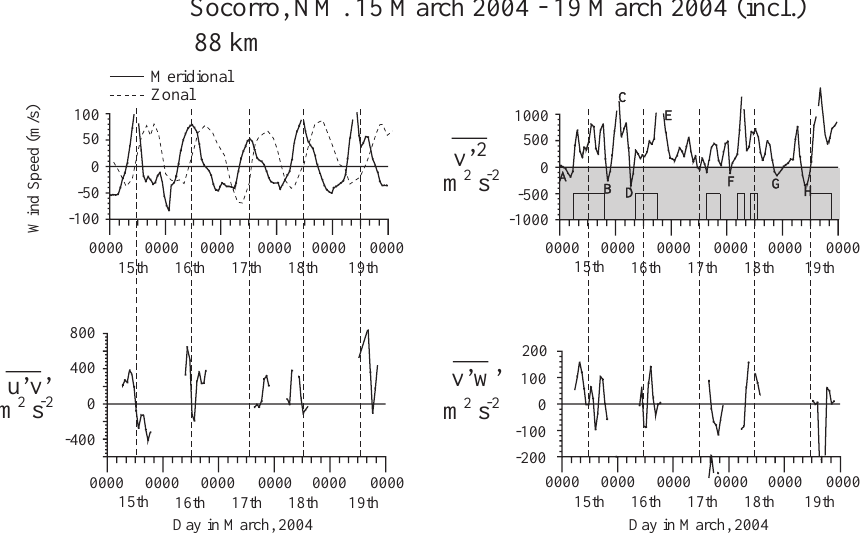
Fig. 1. Examples of mean winds (upper left), northward gravity wave variance (upper right), northward flux of zonal momentum (and also the eastward flux of meridional momentum) (lower left) and vertical flux of meridional momentum (lower right) for Socorro NM, using 90min data sets. See text for